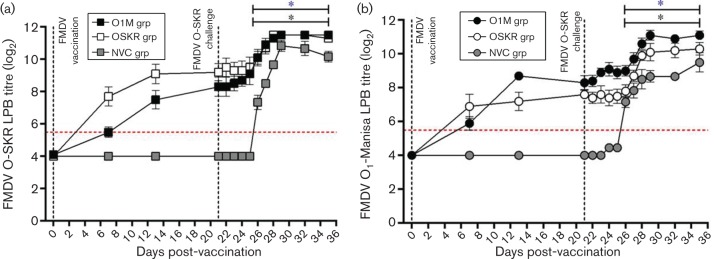
Kinetics of the FMDV O-serotype-specific liquid-phase-blocking antibody response in cattle post-vaccination and live-virus challenge. Kinetics of the (a) FMDV O-SKR-specific and (b) FMDV O1-Manisa-specific liquid-phase-blocking antibody titres post-vaccination and FMDV O-SKR live-virus challenge in the FMDV O1-Manisa vaccinated cohort (black symbols), the FMDV-O-SKR-vaccinated cohort (open symbols) and the non-vaccinated controls (grey symbols). Results are expressed as the log10 transformed grouped mean of duplicate determinations from each calf±sd Statistically significant time points, as compared with 0 dpc (P≤0.05), indicated by * symbol (FMDV O1-Manisa vaccinated cohort = black, FMDV O-SKR vaccinated cohort = blue).